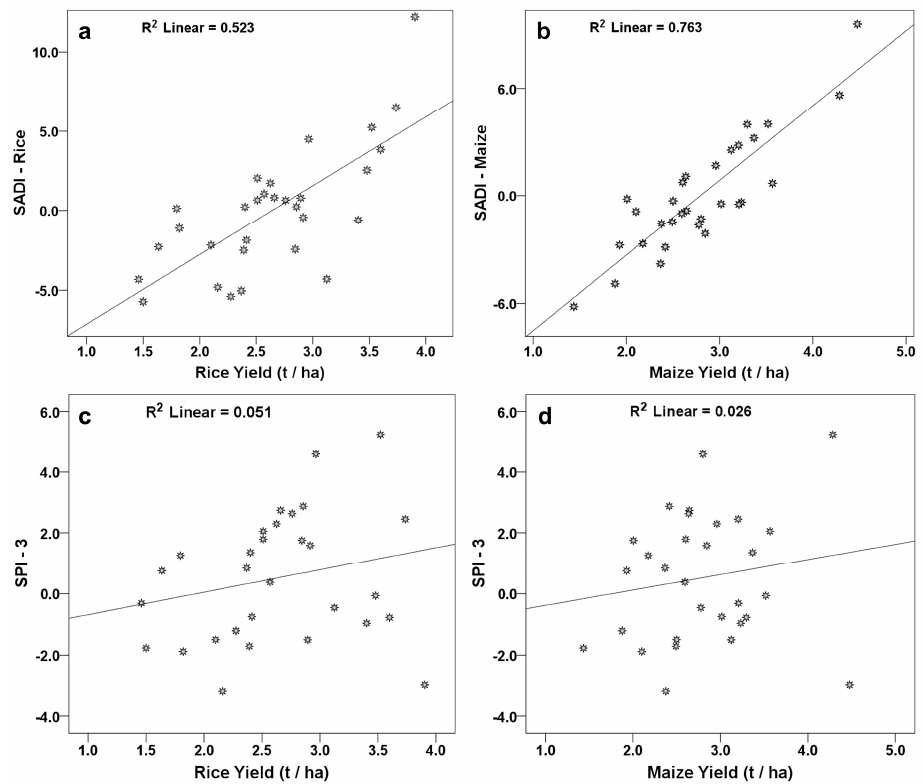
Figure 5. Linear regression for the Standardized Agricultural Drought Index (SADI), three-month Standardized Precipitation Index (SPI-3), and crop yield (( a ): SADI-Rice and rainfed rice yield, ( b ): SADI-Maize and rainfed maize yield, ( c ): SPI-3 and rainfed rice yield, and ( d ): SPI-3 and rainfed maize yield).